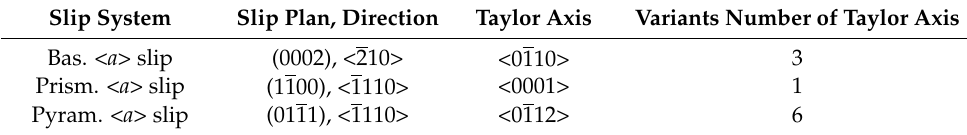
Table 1. Slip modes available in α -Zr and the corresponding Taylor